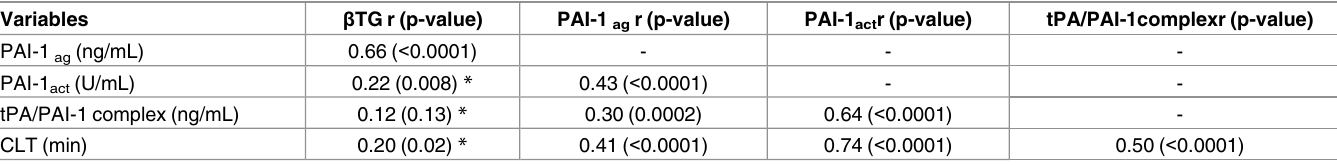
Table 3. Spearman rank order correlations between β TG, PAI-1 assaysand CLT in SABPA study group.